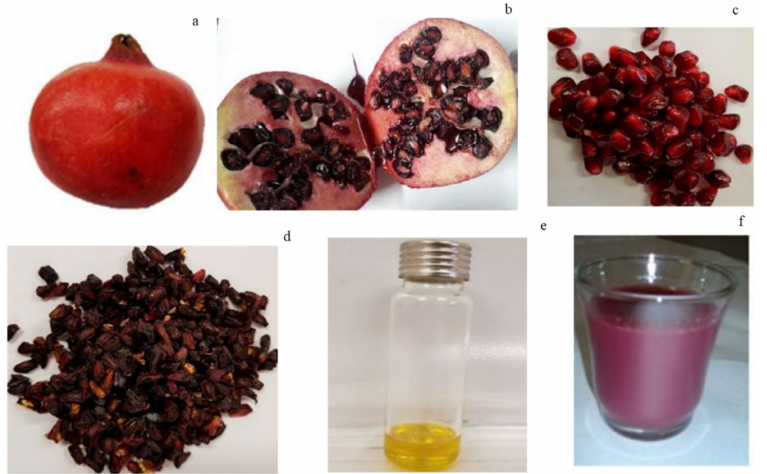
Figure 1. Pomegranate whole fruit and its different products—( a ) whole fruit, ( b ) fresh-cut fruit, ( c ) fresh aril, ( d ) dried aril, ( e ) seed oil, ( f )